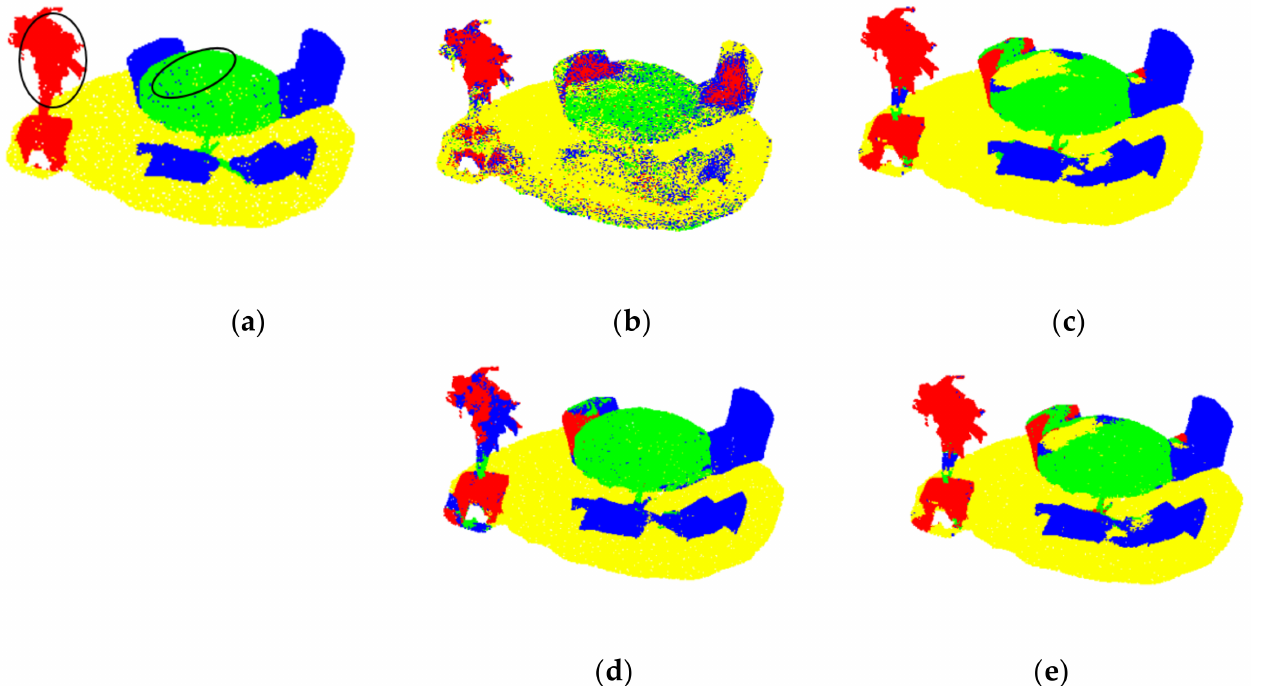
Figure 13. Classification results for Scene 5. ( a ) Ground truth; ( b ) Method 1; ( c ) Method 2; ( d ) Method 3; and ( e ) our method. Red, green, blue, and yellow points represent flowers, tables, chairs, and floors,